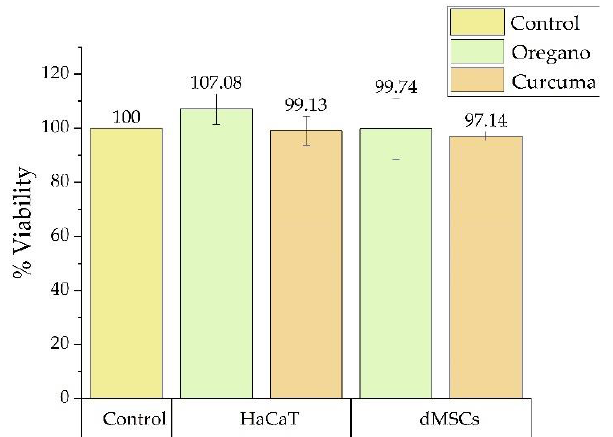
Figure 1. Cell viability of photosensitizers on human dental pulp mesenchymal stem cells (dMSCs) and human keratinocyte cell lines (HaCaT) compared with untreated control. Each bar represents mean and standard deviation ( n = 3).